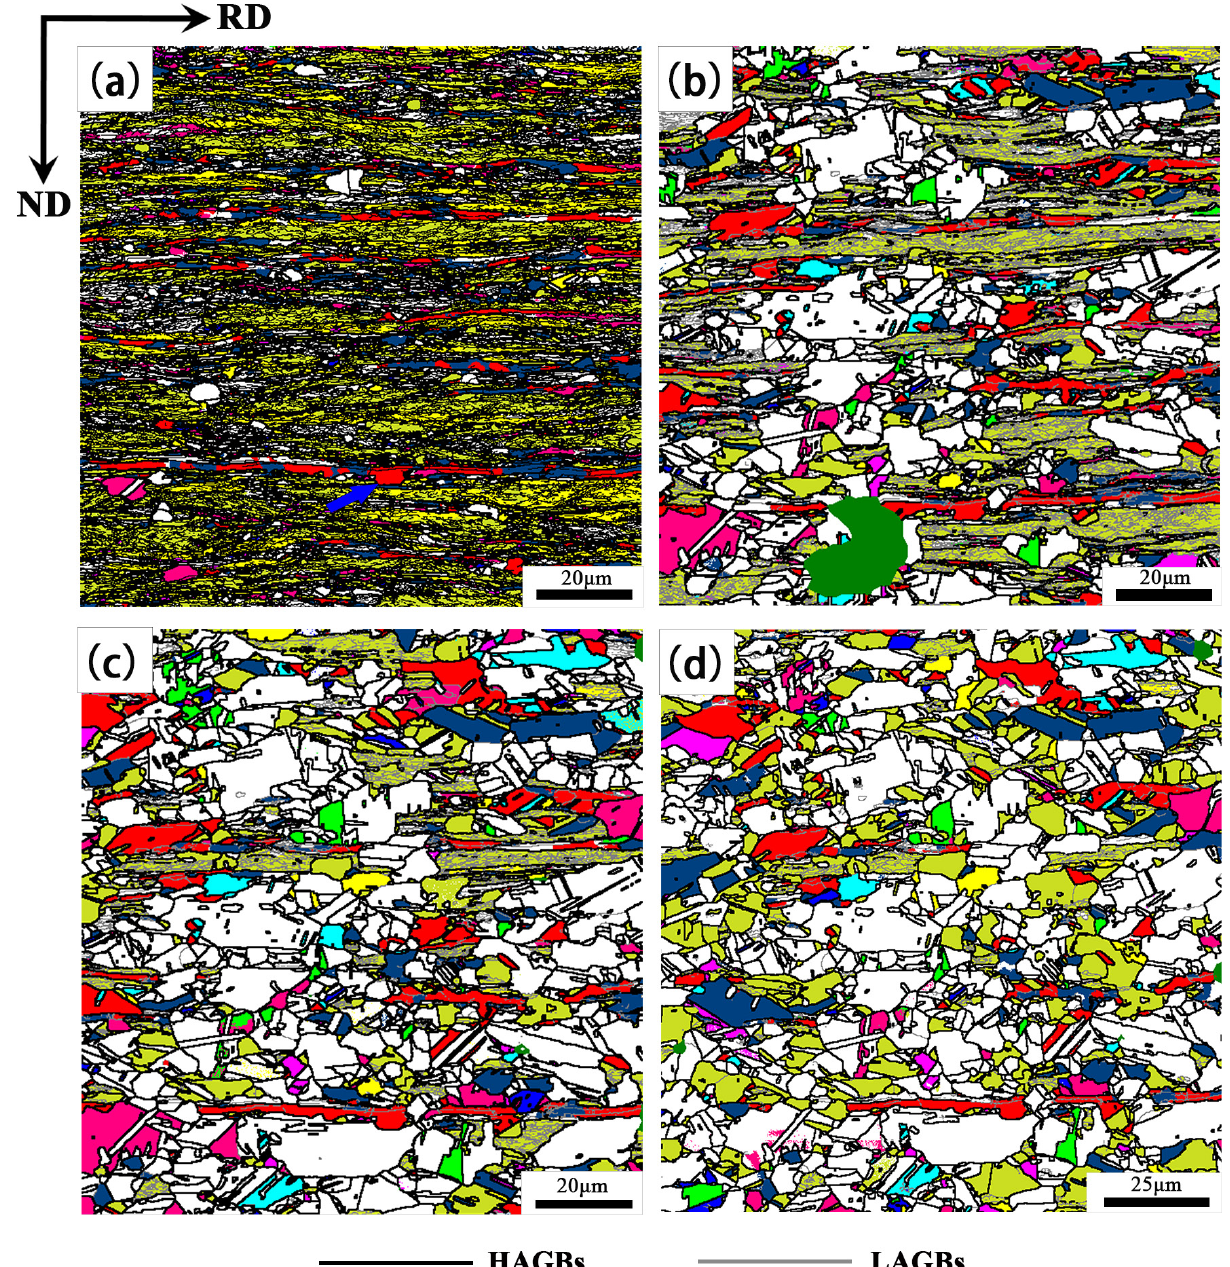
Figure 8: Microstructure evolution of the CCR processed nickel during in-situ annealing at 550 ∘ C for (a) 10 min, (b) 20 min, (c) 45 min and (d) 90